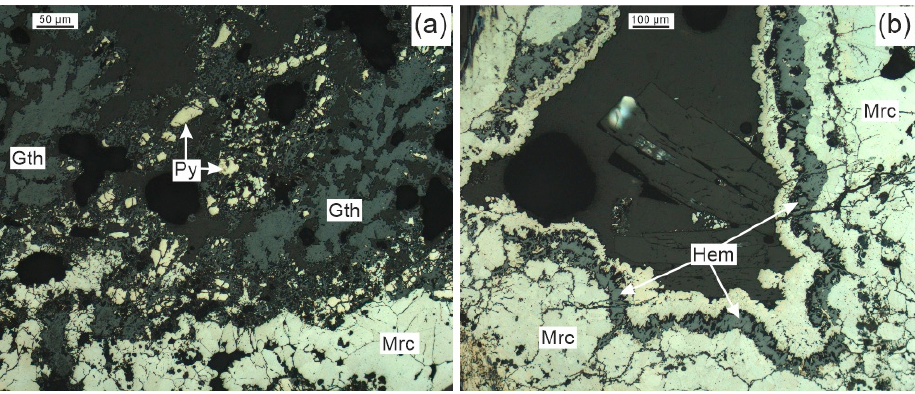
Figure 17. Fe ‐ Oxides in sulfide samples from st. 373. BSE images. ( a ) Hematite ‐ goethite dendrites in Figure 17. Fe-Oxides in sulfide samples from st. 373. BSE images. ( a ) Hematite-goethite dendrites the cavity (sample 373 ‐ 3/1). ( b ) Interlayer of hematite in rhythmically layered marcasite. In the cen ‐ in the cavity (sample 373-3/1). ( b ) Interlayer of hematite in rhythmically layered marcasite. In the ter of the cavity—baryte crystals (sample 373 ‐ 3/1). center of the cavity—baryte crystals (sample 373-3/1).